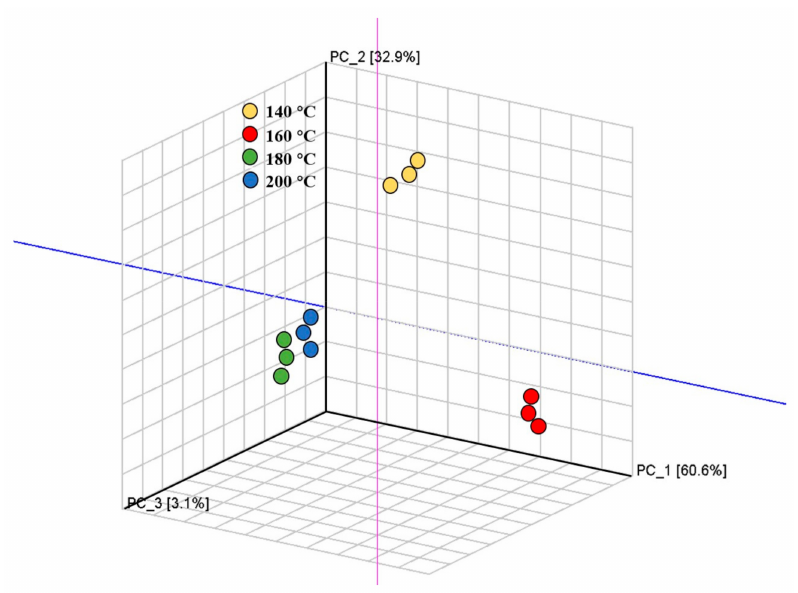
Figure 7. Three-dimensional principal component analysis (PCA) scores of volatile organic com- pounds (VOCs) in fish filets samples of different temperatures with a moisture content of